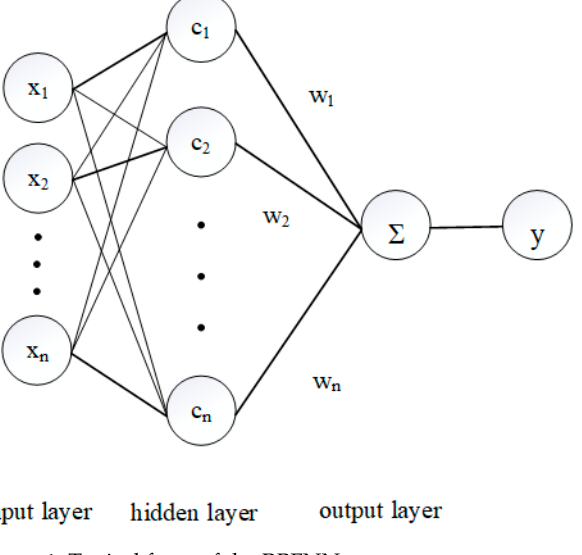
Figure 1. Typical form of the RBFNN.